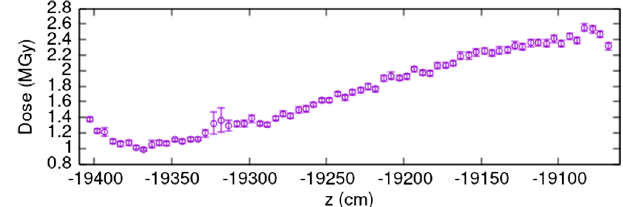
FIG. 8. Longitudinal peak dose profile in the coils along the MBW.B6L7 length fora cumulative loss of10 16 topenergyprotons per beam on the collimation system. The dose is evaluated with a resolution of 0.25, 0.25, and 5 cm in x-y-z, respectively.